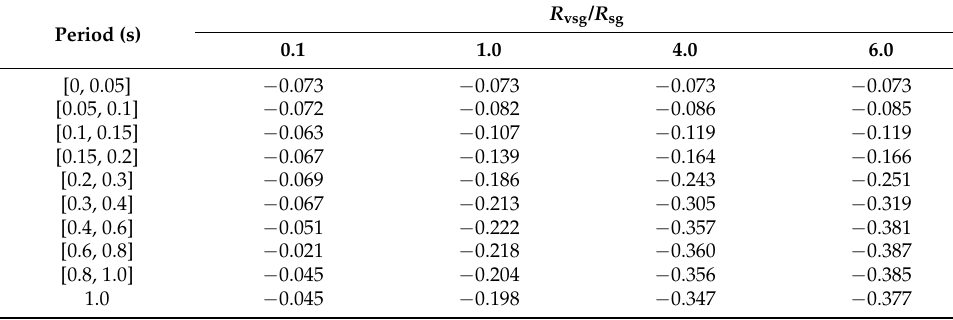
Table A3. Maximum frequency deviations (Hz) ( R vsg was